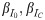
Behaviour of the epidemiological model of PRRS virus spread and control in a population of 50 herds when assuming no intervention from the social planner (5 000 replications).(A) Median number of virus-free herds (F + Fd). (B) Median number of infected controlled herds (IC). The 90% confidence interval [5th percentile; 95th percentile] was provided for each graph in light blue. (C) Contribution of each tested parameter to output variance (βI, βI0,βIC, out,γ,α,ν,κ,φ,δ) after 50 years with the principal effect in blue and the effect associated to first order interactions in red (see Table 2 for parameter definition).